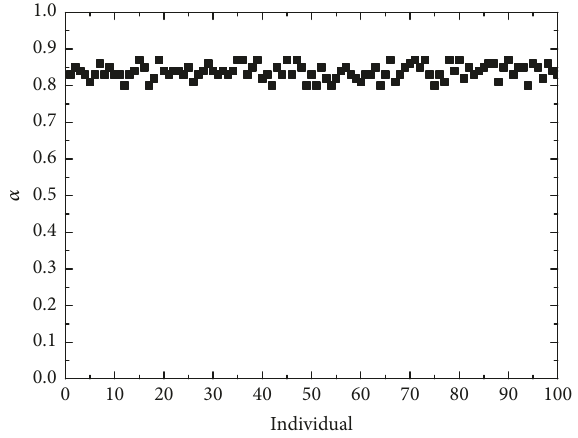
Figure 8: The value 𝛽 of carpooling states.